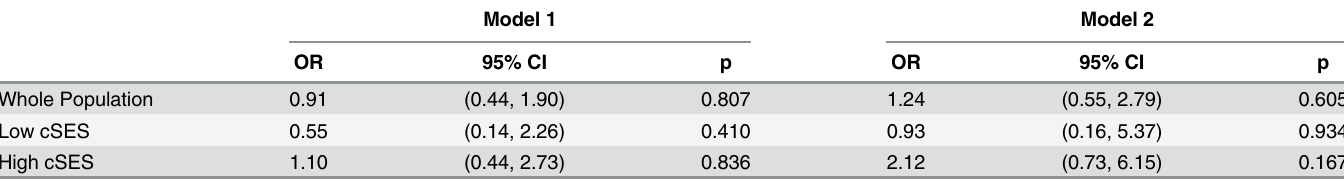
were coarsened to facilitate matching Model 2: Model 1 with additional adjustment for respondent ’ s education (linear spline) Five observations were dropped in the low cSES model because both fair (2 observation) and poor (3 observations) childhood health perfectly predicted not having elevated depressive